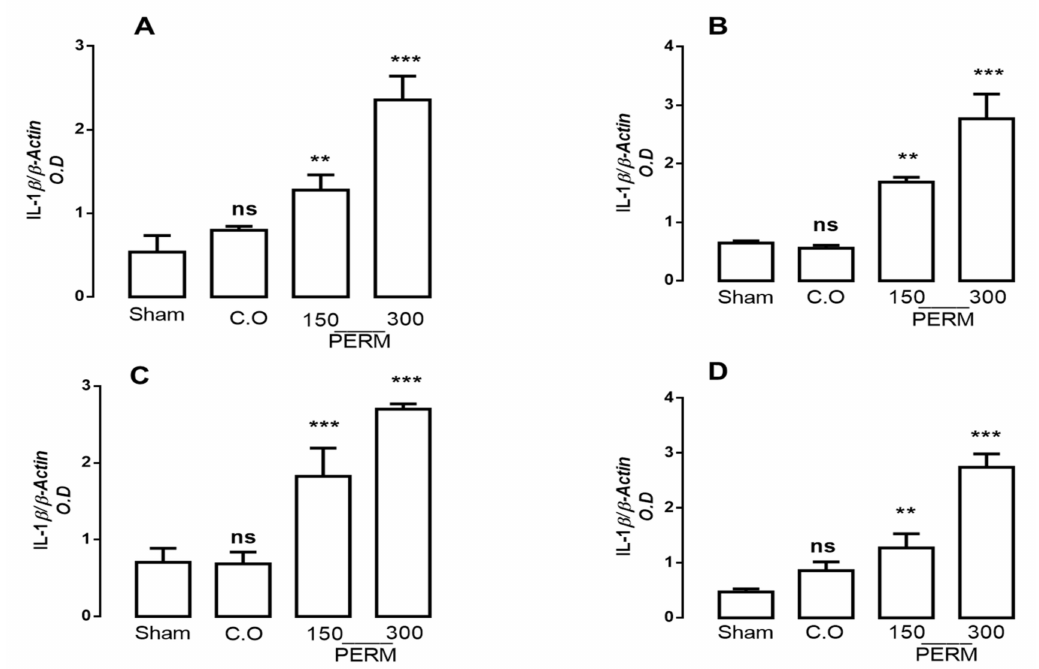
Figure 2. mRNA expression for IL-1 β in the cerebellum ( A ), cerebral cortex ( B ), cerebral hemispheres ( C ) and medulla ( D ) in rats treated with corn oil (control group), permethrin 150 mg/kg or 300 mg/kg, and rats without treatment (sham group). Values are mean ± SD ( n = 4 for each group). The results were analyzed with ANOVAs followed by Bonferroni’s multiple comparisons tests to compare permethrin (150 or 300 mg/kg) groups versus the control group (sham). Data from 6 independent experiments run in quadruplicate. Without statistically different is showed as ns. ** p < 0.001 vs. sham group; and *** p < 0.0001 vs. sham group; CO (Corn oil); PERM